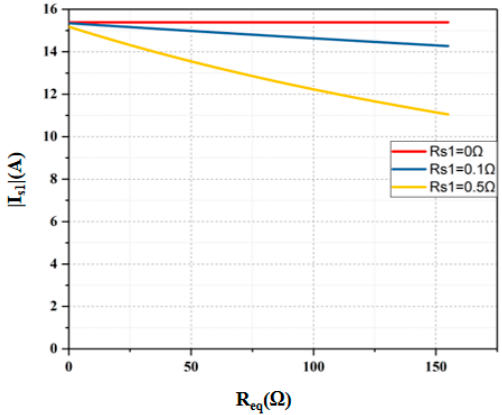
Figure 13. Compensation networks of ( a ) S-S; ( b ) S-LCL.